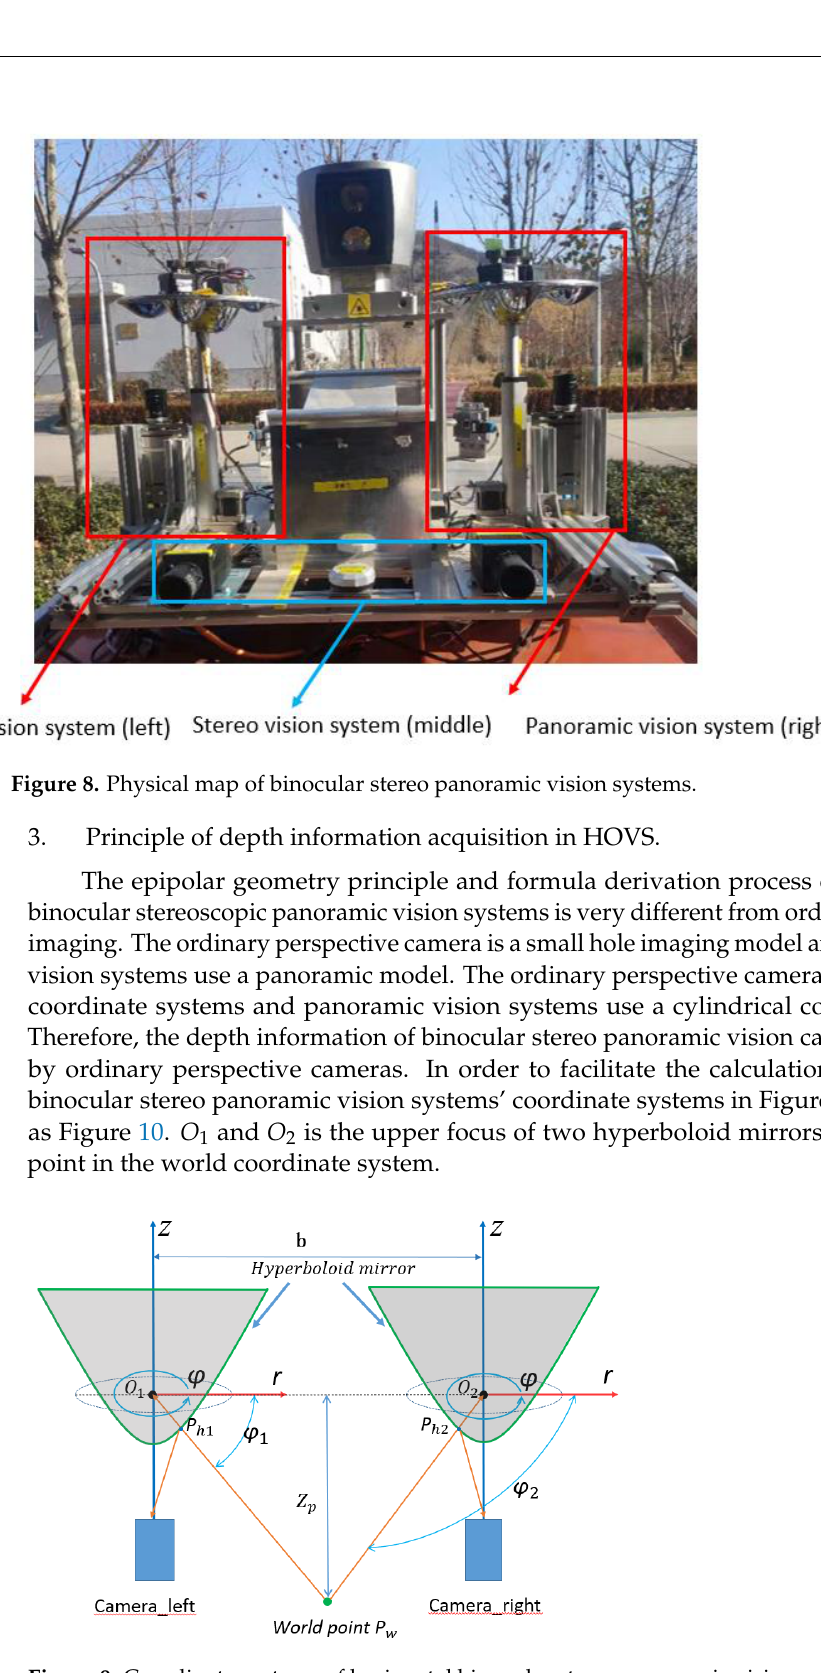
Figure 7. The physical picture of monocular panoramic vision systems.